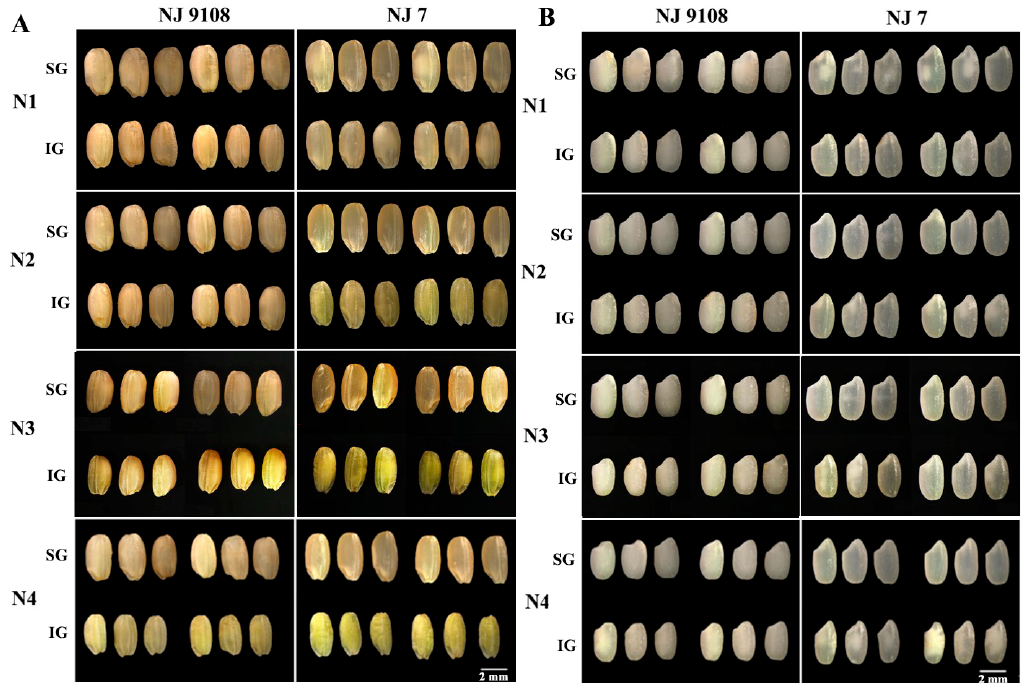
Figure 1. Morphological changes of superior and inferior grains under different nitrogen fertilizer levels. ( A ), brown rice; ( B ), milled rice. SG, the superior grain; IG, the inferior grain. N1: 0 kg N·hm − 2 , N2: 195 kg N·hm − 2 , N3: 270 kg N·hm − 2 , N4: 345 kg N·hm − 2 . N2: 195 kg N · hm − 2 , N3: 270 kg N · hm − 2 , N4: 345 kg N · hm − 2